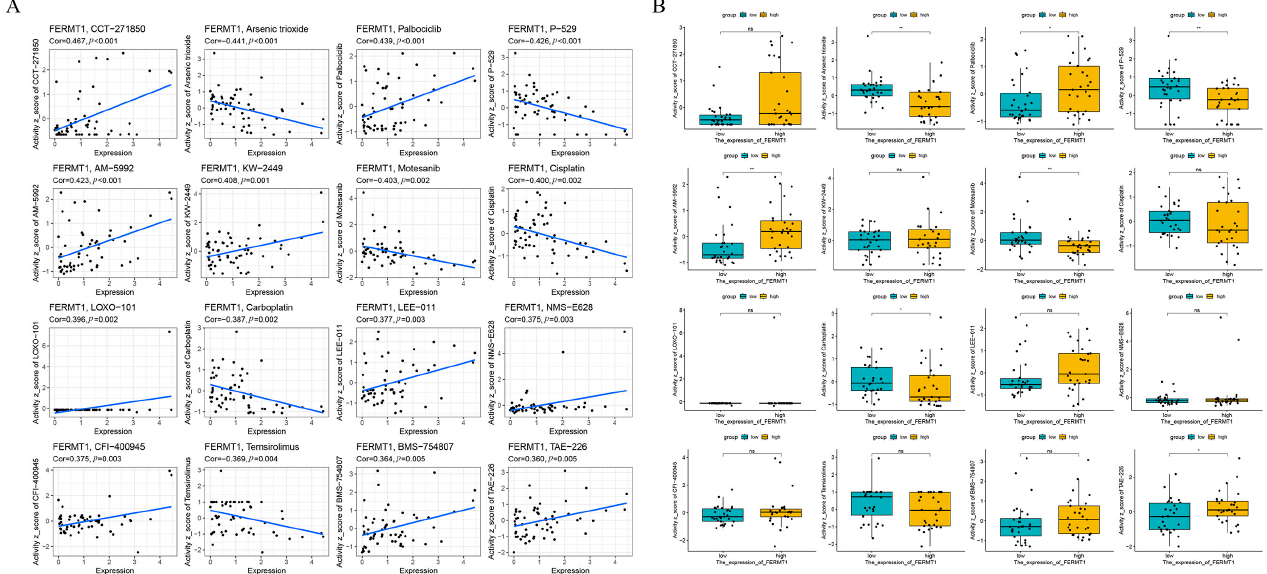
Figure 10. Correlation between FERMT1 and drug sensitivity. ( A ) Correlation between FERMT1 and the top 16 anti-cancer drugs with sensitivity in the CellMiner database. ( B ) The sensitivity value of different drugs between the low and high FERMT1 expression groups. * p < 0.05, ** p < 0.01, ns, no signi fi cant di ff erence.